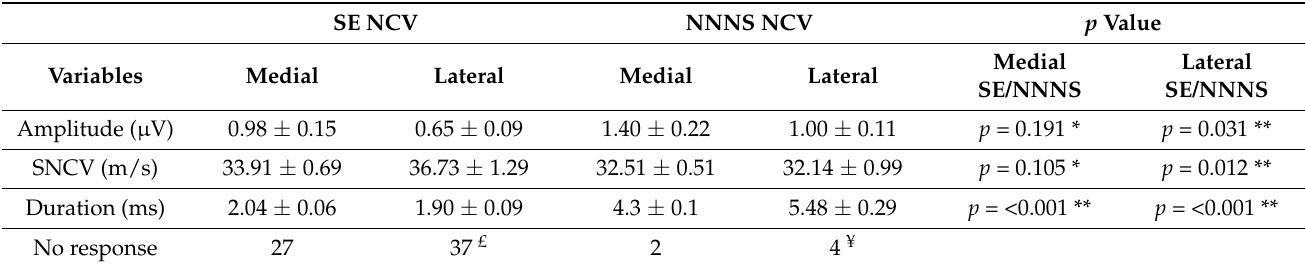
Figure 4. Sensory nerve action potentials (SNAP) recorded for the same patient with surface electrodes ( A ) and the near-nerve needle technique ( B ) at the level of the medial malleolus with stimulus at the I and V digits separately for the evaluation of the medial and lateral plantar branch. A clear difference is observed between the two tests for the maximum NCV (MaxNCV) and duration, although the greater difference is more evident for the lateral plantar branch. minimum NCV (MinNCV) is shown in red. Table 1. Comparison between SE and ultrasound-guided (UGS)-NNNS NCV techniques.